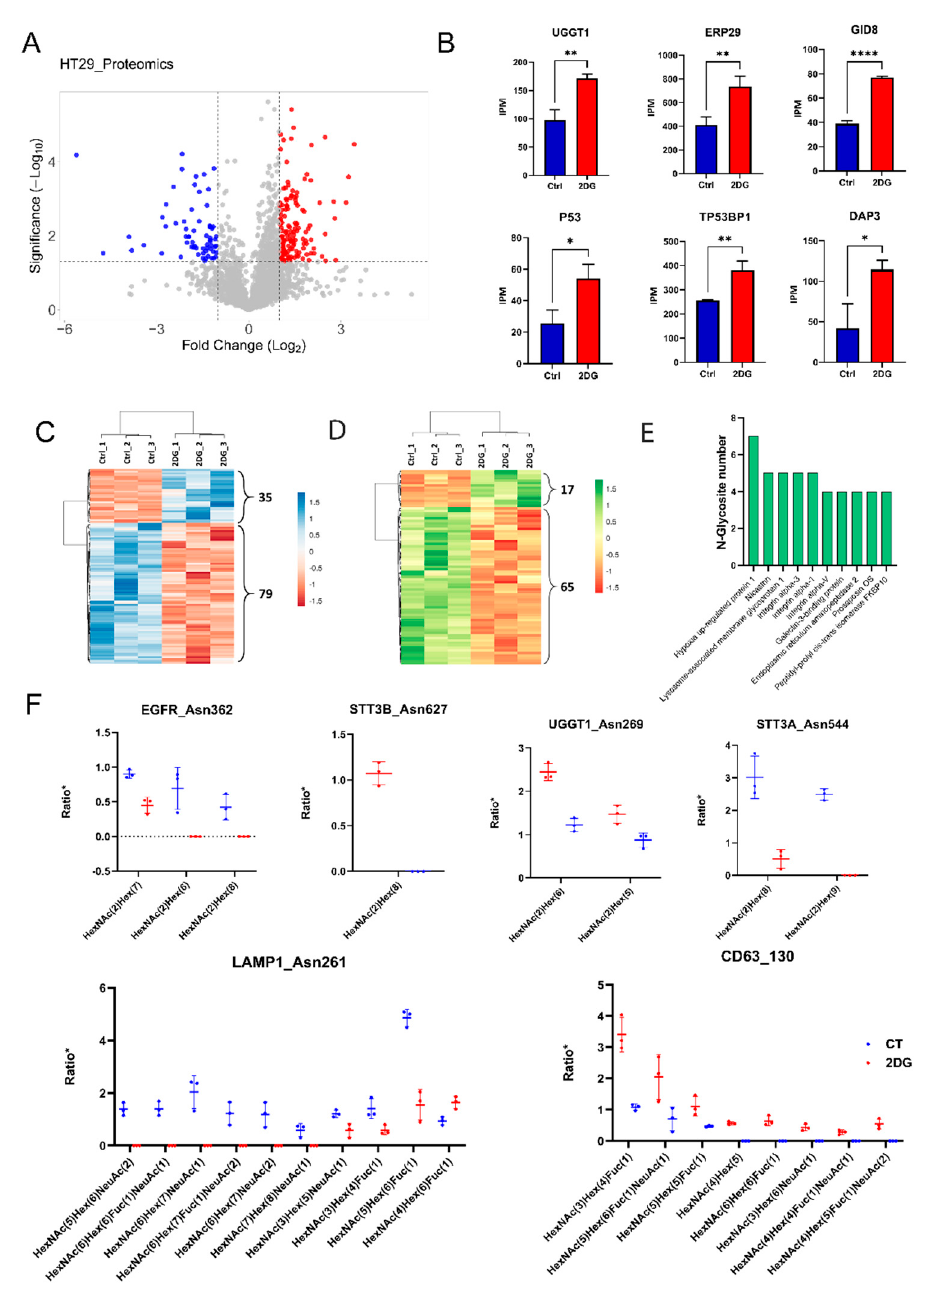
Figure 1. Analysis of the global protein expressional changes and N -glycosylation alterations in 2DG-treated HT29 cells. ( A ) Volcano plot displaying the distribution of all proteins with relative protein abundance (2DG/CT fold change ≥ 2 with p -value < 0.05, red color; 2DG/CT fold change ≤ 0.5 with p -value < 0.05, blue color. *, **, and **** indicates a p -value < 0.05, 0.01, and 0.001, respectively). ( B ) Exemplification of six up-regulated proteins associated with 2DG treatment, including UGGT1, UGT1A10, ERP29, TP53, P53I11, and GDI8 (red color represents the relative protein abundance